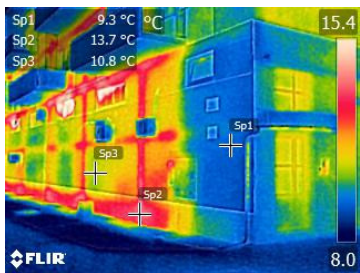
Figure 2. An example of highly-visible structural elements as well as a heated and an unheated